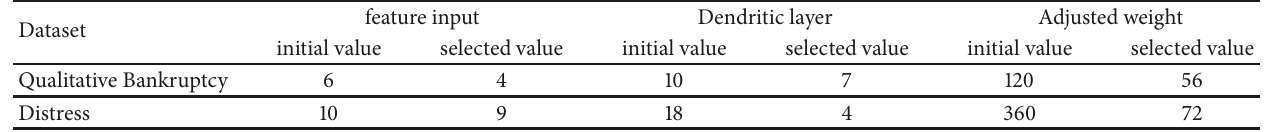
Figure 15: The final structure of the Distress data set. Table 15: Model structure comparison between Qualitative Bankruptcy and Distress data sets.